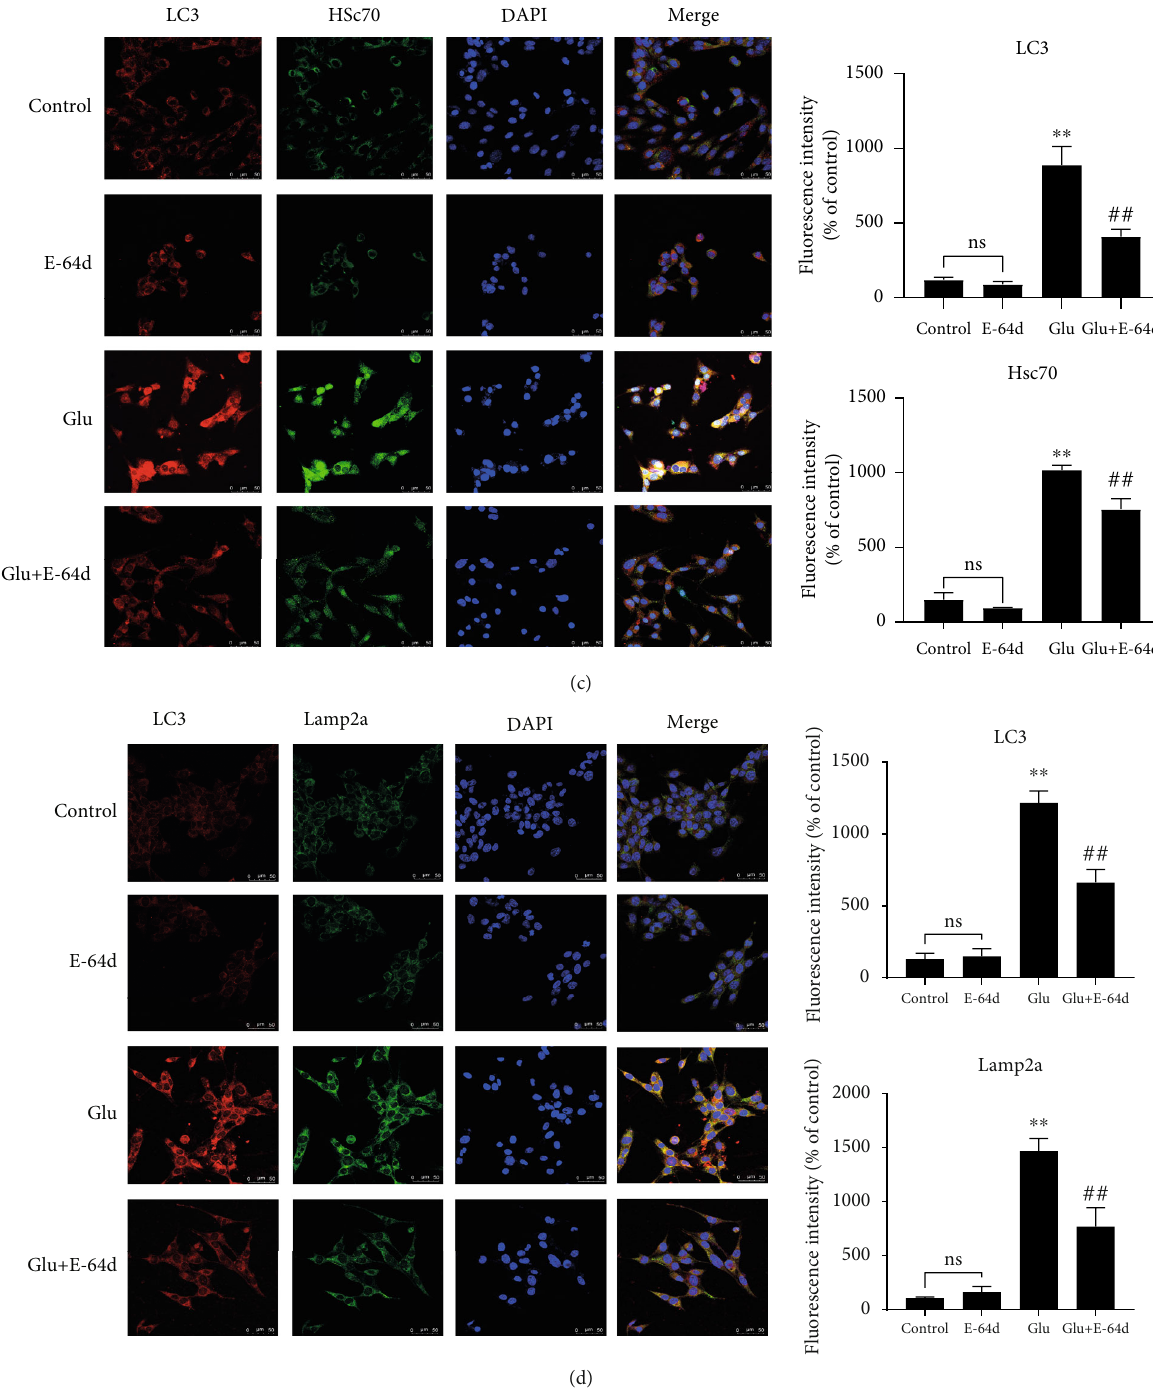
Figure 6: E ff ect of E-64d on protein expression of Cytc (a), Drp1 (b), Hsc70 (c), and Lamp2a (d) in HT22 cells, as determined by laser confocal microscopy. The four groups were stained with anti-LC3 antibodies (red); anti-Cytc, Drp1, Hsc70, and Lamp2a antibodies (green); and DAPI (blue, cell nuclei labeling). The results of the quantitative analysis of average fl uorescence intensity are shown. ∗∗ P < 0 : 01 vs. the Control group. ## P < 0 : 01 vs. the Glutamate group. n.s.: not signi fi